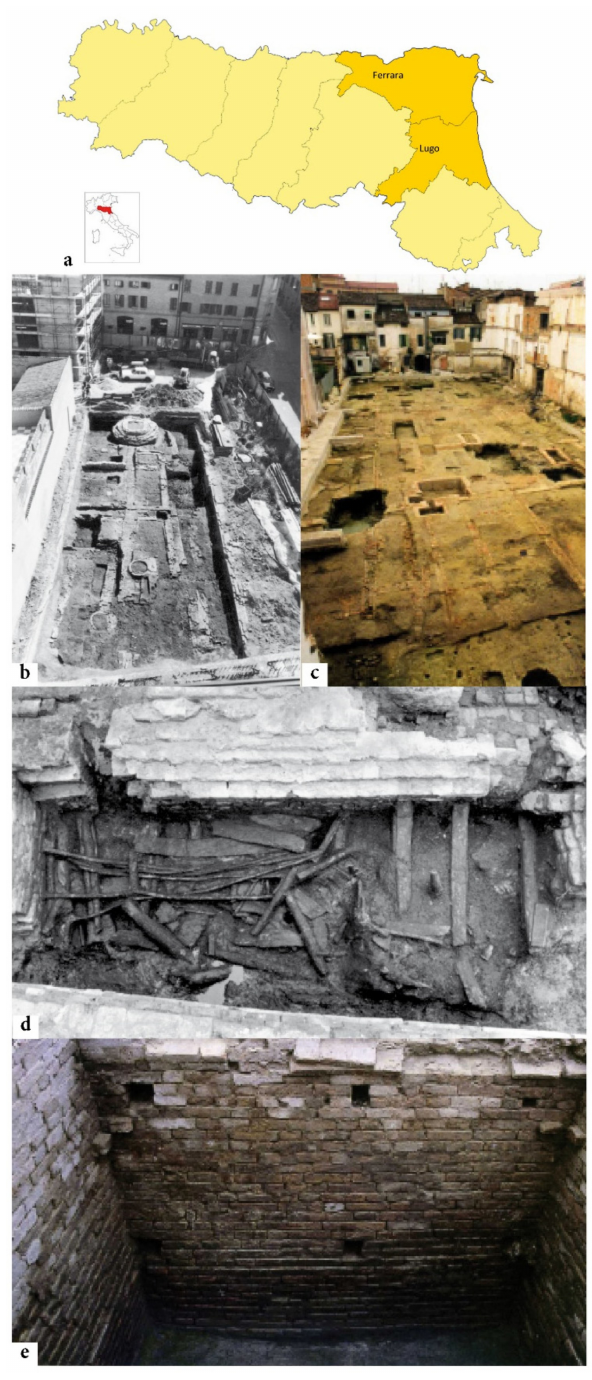
Figure 1. The two archaeological sites examined: Ferrara (context I—no. 16c) and Lugo (context II—no. 15); geographic location ( a ), overview of archaeological excavation ( b , c ) and pits ( d , e